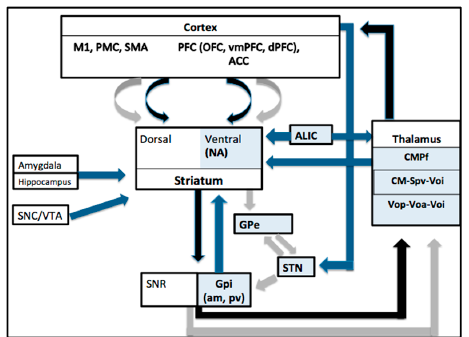
Figure 1. Simplified schematic showing the main connections of the cortico-thalamo-cortical network, with the nuclei targeted in TS DBS in blue boxes (NA = nucleus accumbens, ALIC = anterior limb internal capsule, CMPf centromedian parafasciular complex, CM Sp Voi, centromedian nucleus-substantia periventricularis-nucleus ventro-oralis nucleus, the nucleus ventro-oralis posterior-ventro oralis anterior ventro-oralis complex (Vop-Voa-Voi), GPe = globus pallidus externus, STN = subthalamic nucleus, GPi (am, pv = anteromedial, posteroventral globus pallidus internus). The direct pathway is shown with black arrows, the indirect pathway with grey arrows and other connections shown with blue arrows. Projections from the primary motor cortex (M1), the pre-motor cortex (PMC) and the supplementary motor area (SMA) are predominantly directed to the dorsal striatum (putamen and caudate) whereas fibers from the prefrontal cortex (PFC) including the orbitofrontal cortex (OFC), ventromedial PFC (vmPFC) and the dorsal PFC (dPFC) as well as the anterior cingulate cortex (ACC) mostly project to the ventral striatum (nucleus accumbens and rostroventral most aspects of caudate and putamen). The main output nuclei are the GPi and the substantia nigra pars reticulata (SNR). Other regions, such as the substantia nigra pars compacta (SNC), also have connections with the striatum.